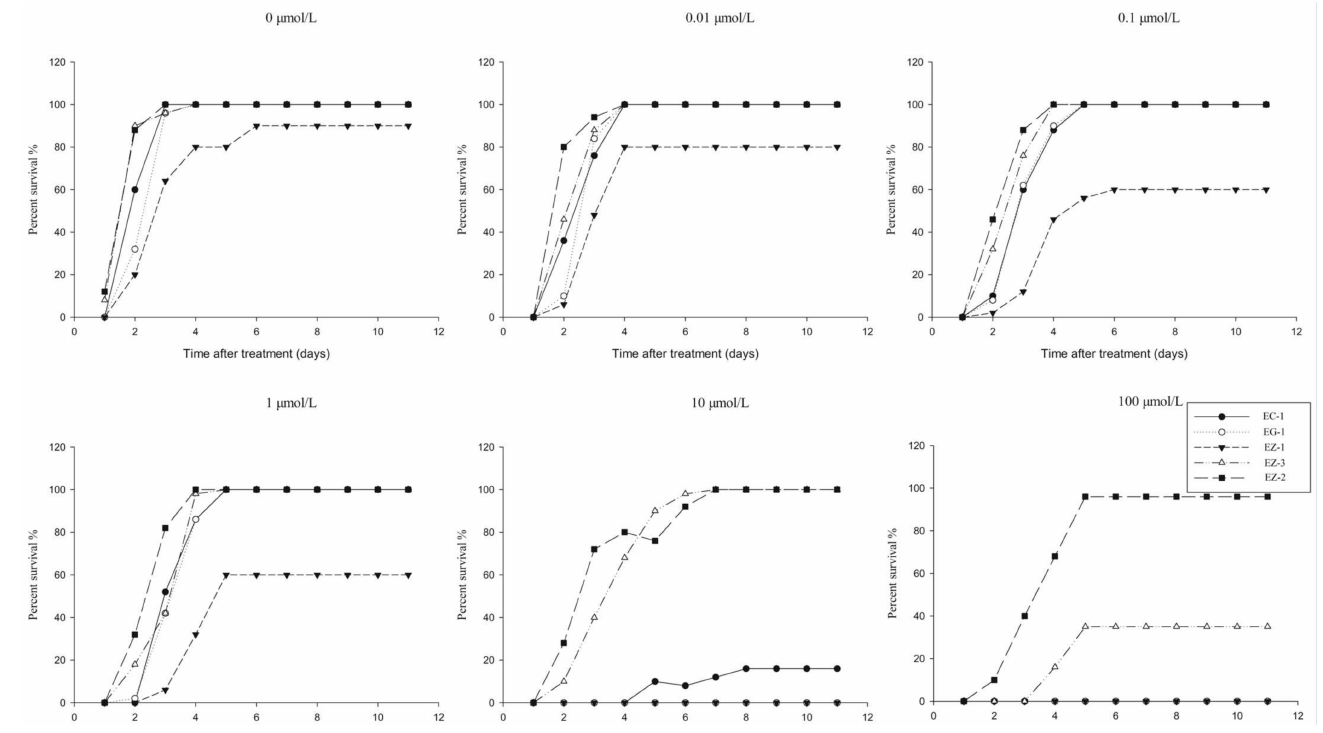
Figure 3. Percentage of daily survival of various biotypes at different quinclorac concentrations